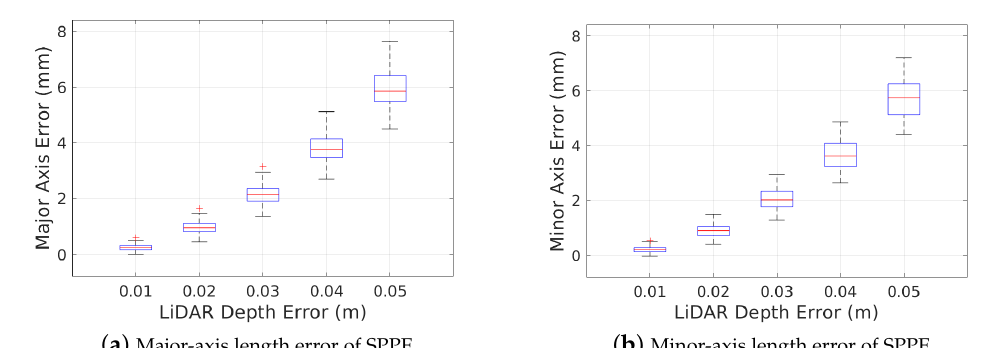
Figure 15. Robustness of SPPE to LiDAR depth error.